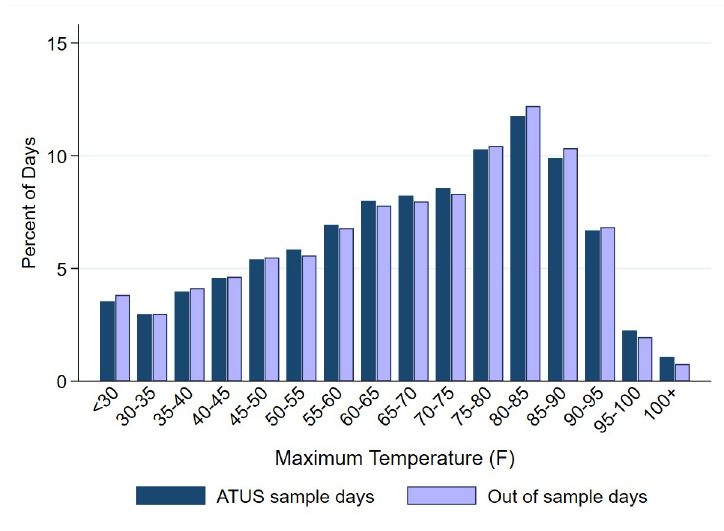
Fig 1. Historical climate. Distribution of daily maximum temperature in counties with ATUS respondents over 1) days with ATUS diary entries in the county (“ATUS sample days”), and 2) days without diary entries (“Out of sample